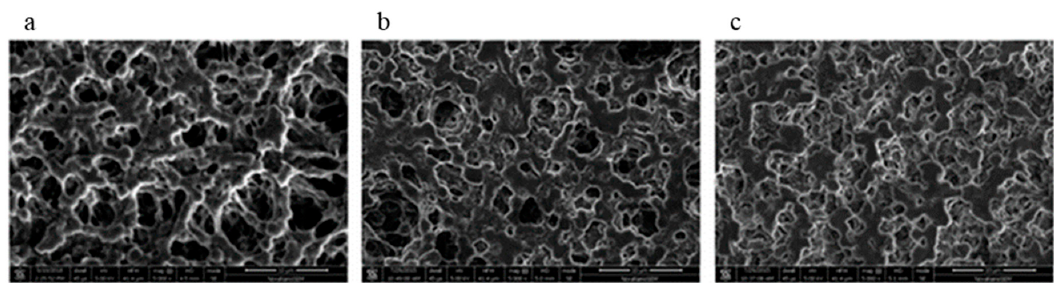
Figure 5. SEM photographs of ( a ) blank PVDF membrane, ( b ) NIM and ( c ) MIM prepared by grafting onto the membrane. Reproduced with permission from [27].